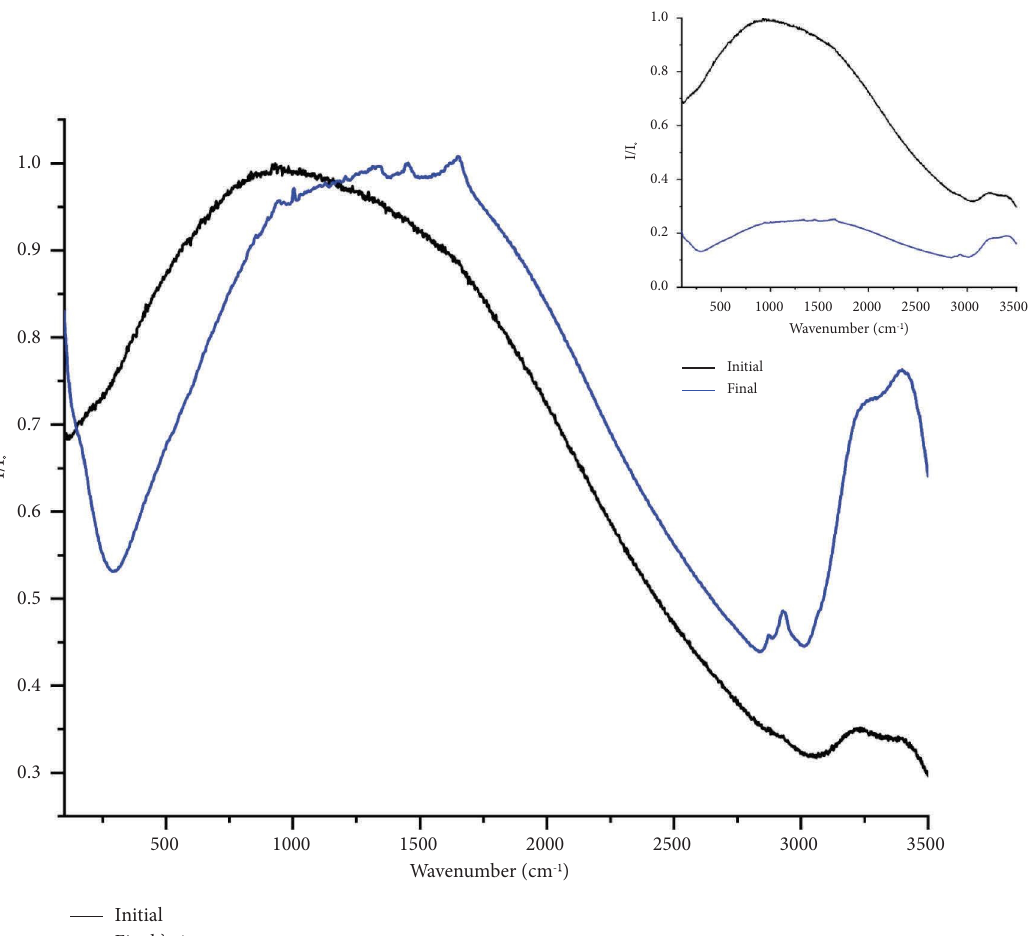
Figure 7: Initial BSA spectrum measured with 1s exposure and 10 accumulations and fnal BSA spectrum (x4) after 72h of photobleaching with the 532nm external laser measured with 10s exposure and 200 accumulations. Inset shows the two spectra without